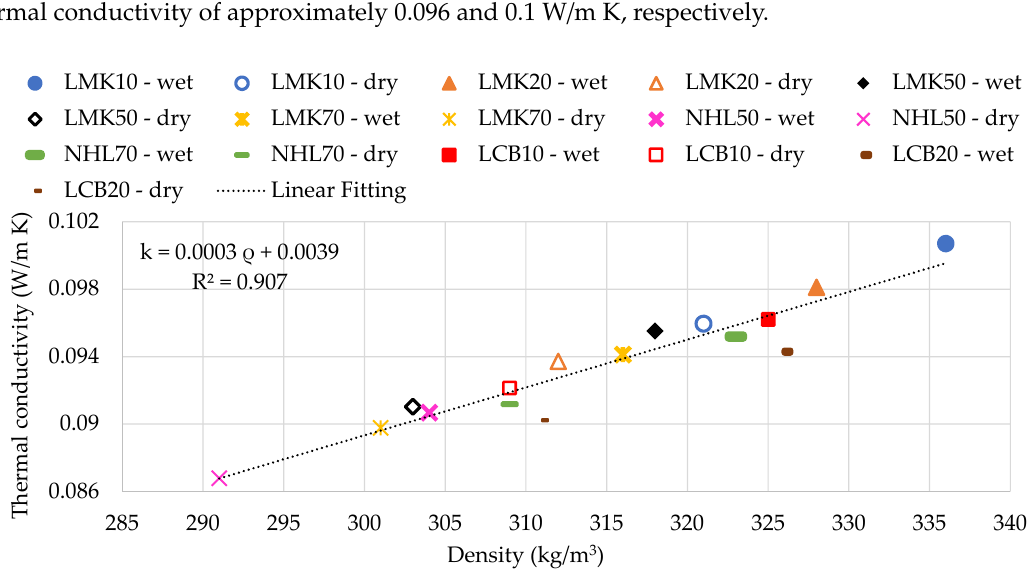
Figure 4 . Thermal conductivity comparison with other studies.